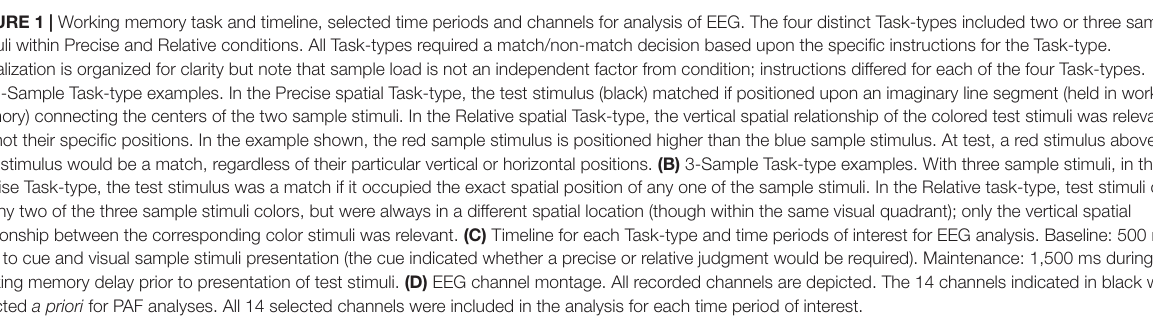
FIGURE 1 | Working memory task and timeline, selected time periods and channels for analysis of EEG. The four distinct Task-types included two or three sample stimuli within Precise and Relative conditions. All Task-types required a match/non-match decision based upon the specific instructions for the Task-type. Visualization is organized for clarity but note that sample load is not an independent factor from condition; instructions differed for each of the four Task-types. (A) 2-Sample Task-type examples. In the Precise spatial Task-type, the test stimulus (black) matched if positioned upon an imaginary line segment (held in working memory) connecting the centers of the two sample stimuli. In the Relative spatial Task-type, the vertical spatial relationship of the colored test stimuli was relevant, but not their specific positions. In the example shown, the red sample stimulus is positioned higher than the blue sample stimulus. At test, a red stimulus above a blue stimulus would be a match, regardless of their particular vertical or horizontal positions. (B) 3-Sample Task-type examples. With three sample stimuli, in the Precise Task-type, the test stimulus was a match if it occupied the exact spatial position of any one of the sample stimuli. In the Relative task-type, test stimuli could be any two of the three sample stimuli colors, but were always in a different spatial location (though within the same visual quadrant); only the vertical spatial relationship between the corresponding color stimuli was relevant. (C) Timeline for each Task-type and time periods of interest for EEG analysis. Baseline: 500 ms prior to cue and visual sample stimuli presentation (the cue indicated whether a precise or relative judgment would be required). Maintenance: 1,500 ms during the working memory delay prior to presentation of test stimuli. (D) EEG channel montage. All recorded channels are depicted. The 14 channels indicated in black were selected a priori for PAF analyses. All 14 selected channels were included in the analysis for each time period of